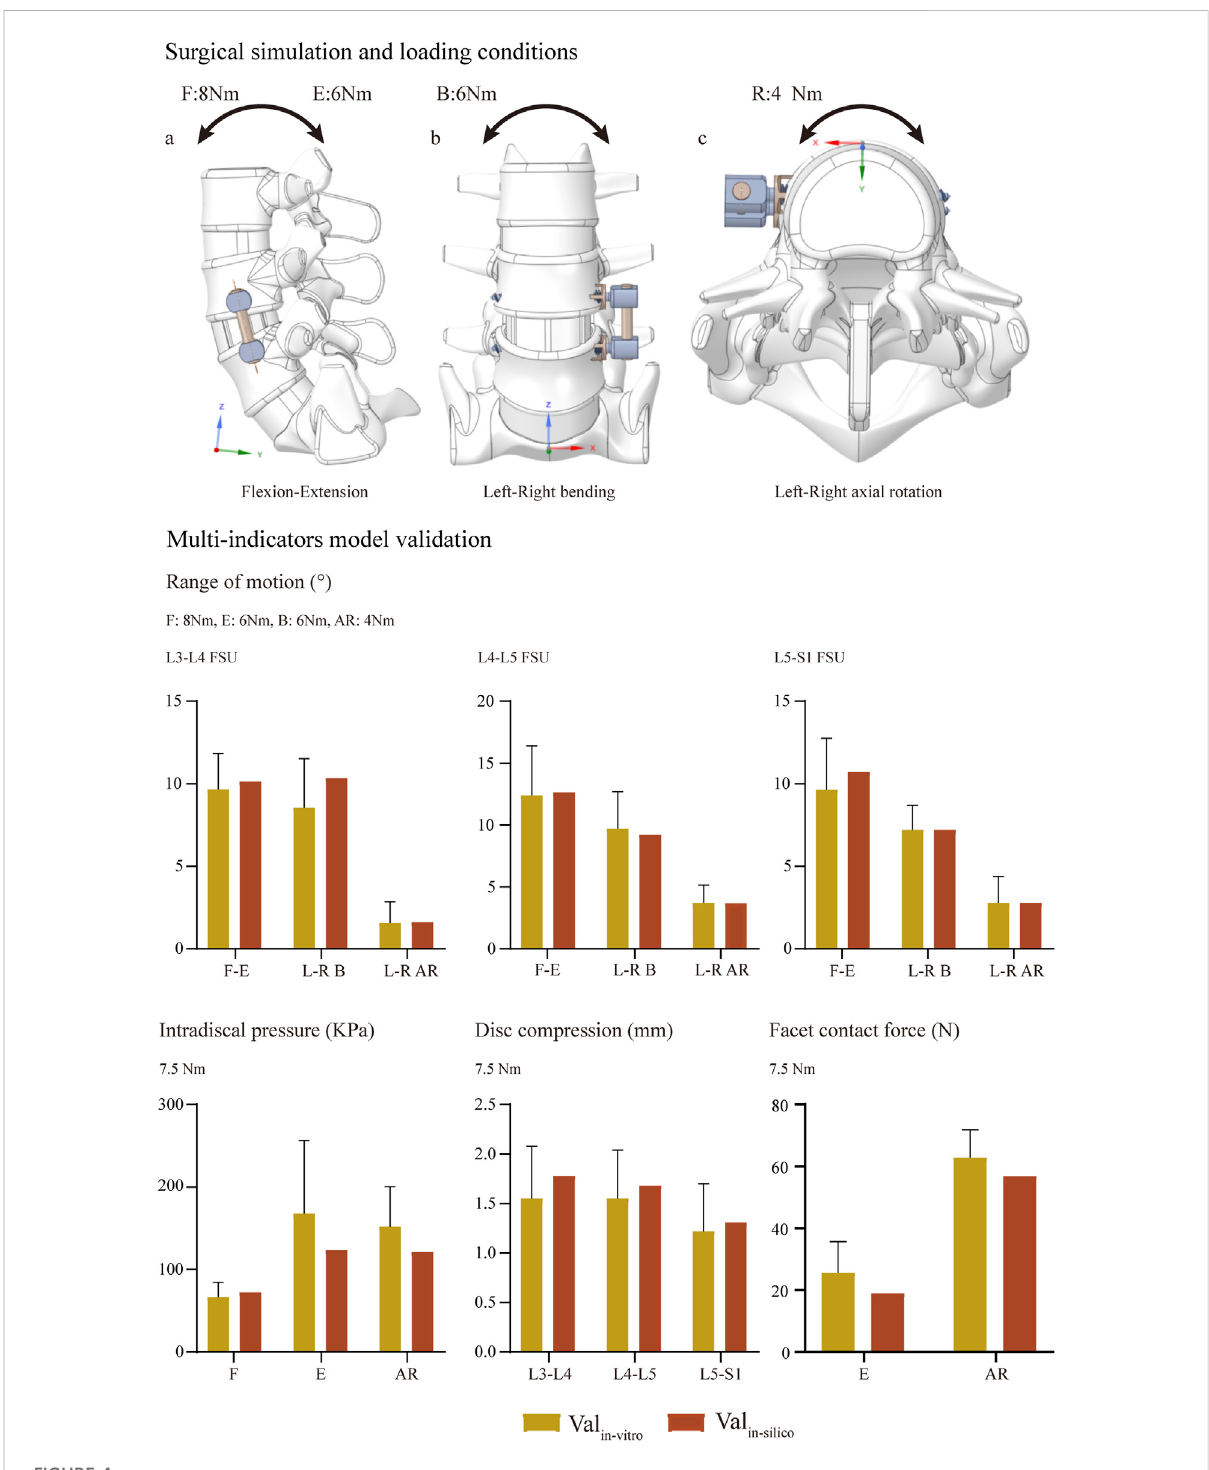
FIGURE 4 Surgical simulations and multi-indicator model validations (Wilson et al., 2006; Renner et al., 2007; Schilling et al., 2011).